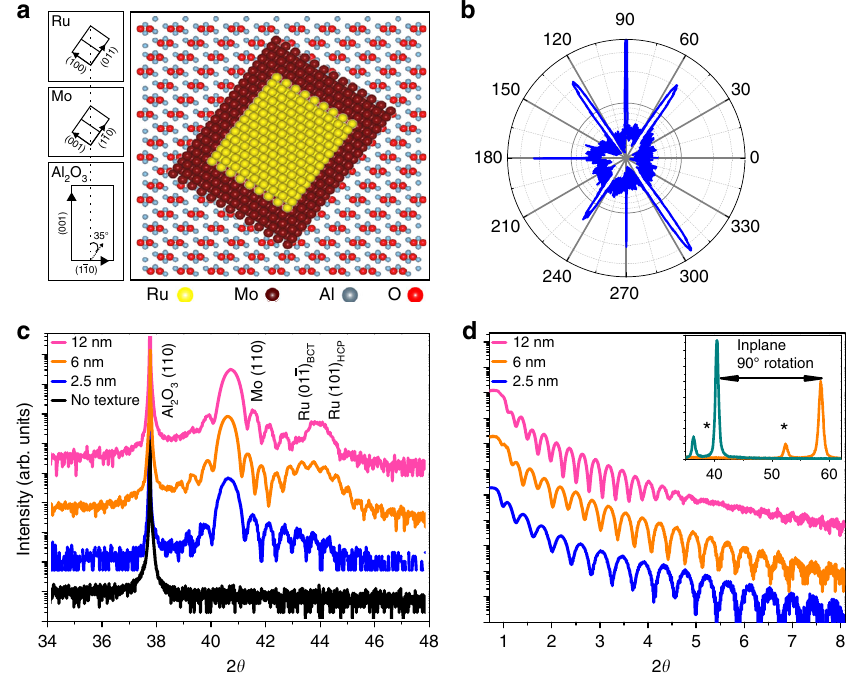
Fig. 1 Epitaxial relation for tetragonal Ru growth. The expected crystallographic structure and epitaxial relation is shown using a a cartoon showing the epitaxial growth relation for (110) Al 2 O 3 //(110) Mo//011Ru, and b X-ray diffraction using grazing incidence, by placing the detector in the (110) plane of Al 2 O 3 and rotating the sample over 360°. c Conventional XRD spectra with the orientation parallel to {110} Al 2 O 3 , and d X-ray re fl ectivity for 2.5, 6, and 12 nm Ru fi lms; with the inset of d showing the grazing incidence coupled scan when aligned to the short (black) and long (blue) edge of (110)